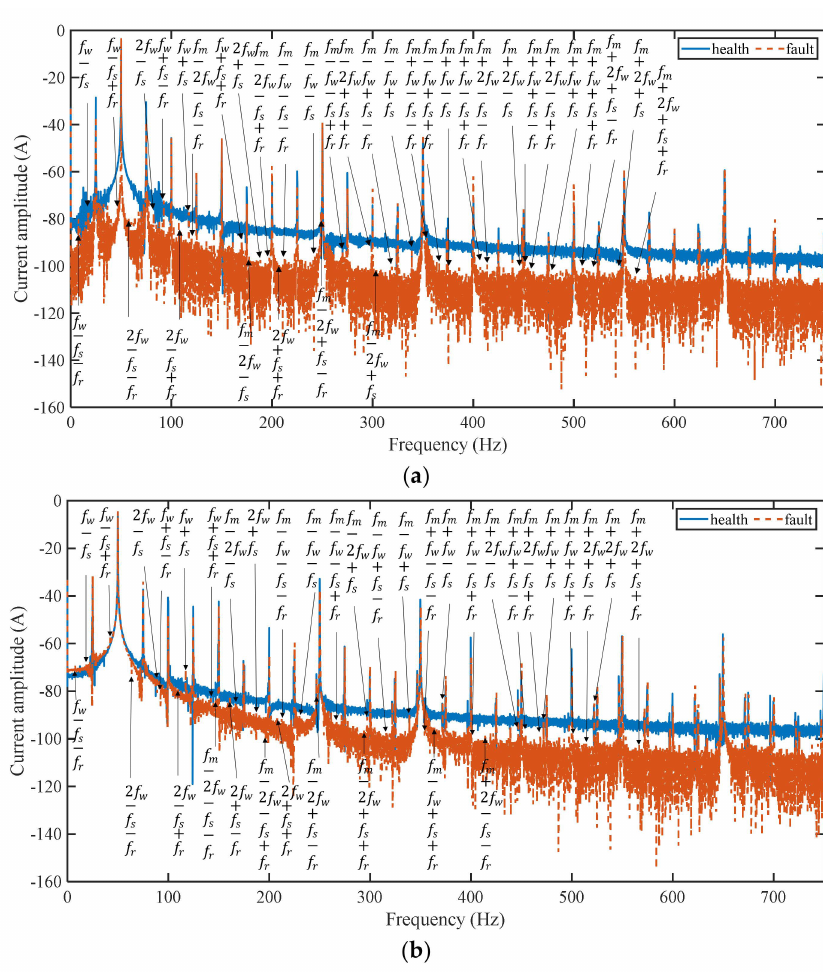
Figure 16. Stator current spectrum at different torques tested for the chipping teeth at the sun gear. ( a ) Torque = 0 N · m and ( b ) torque = 10.5 N ·